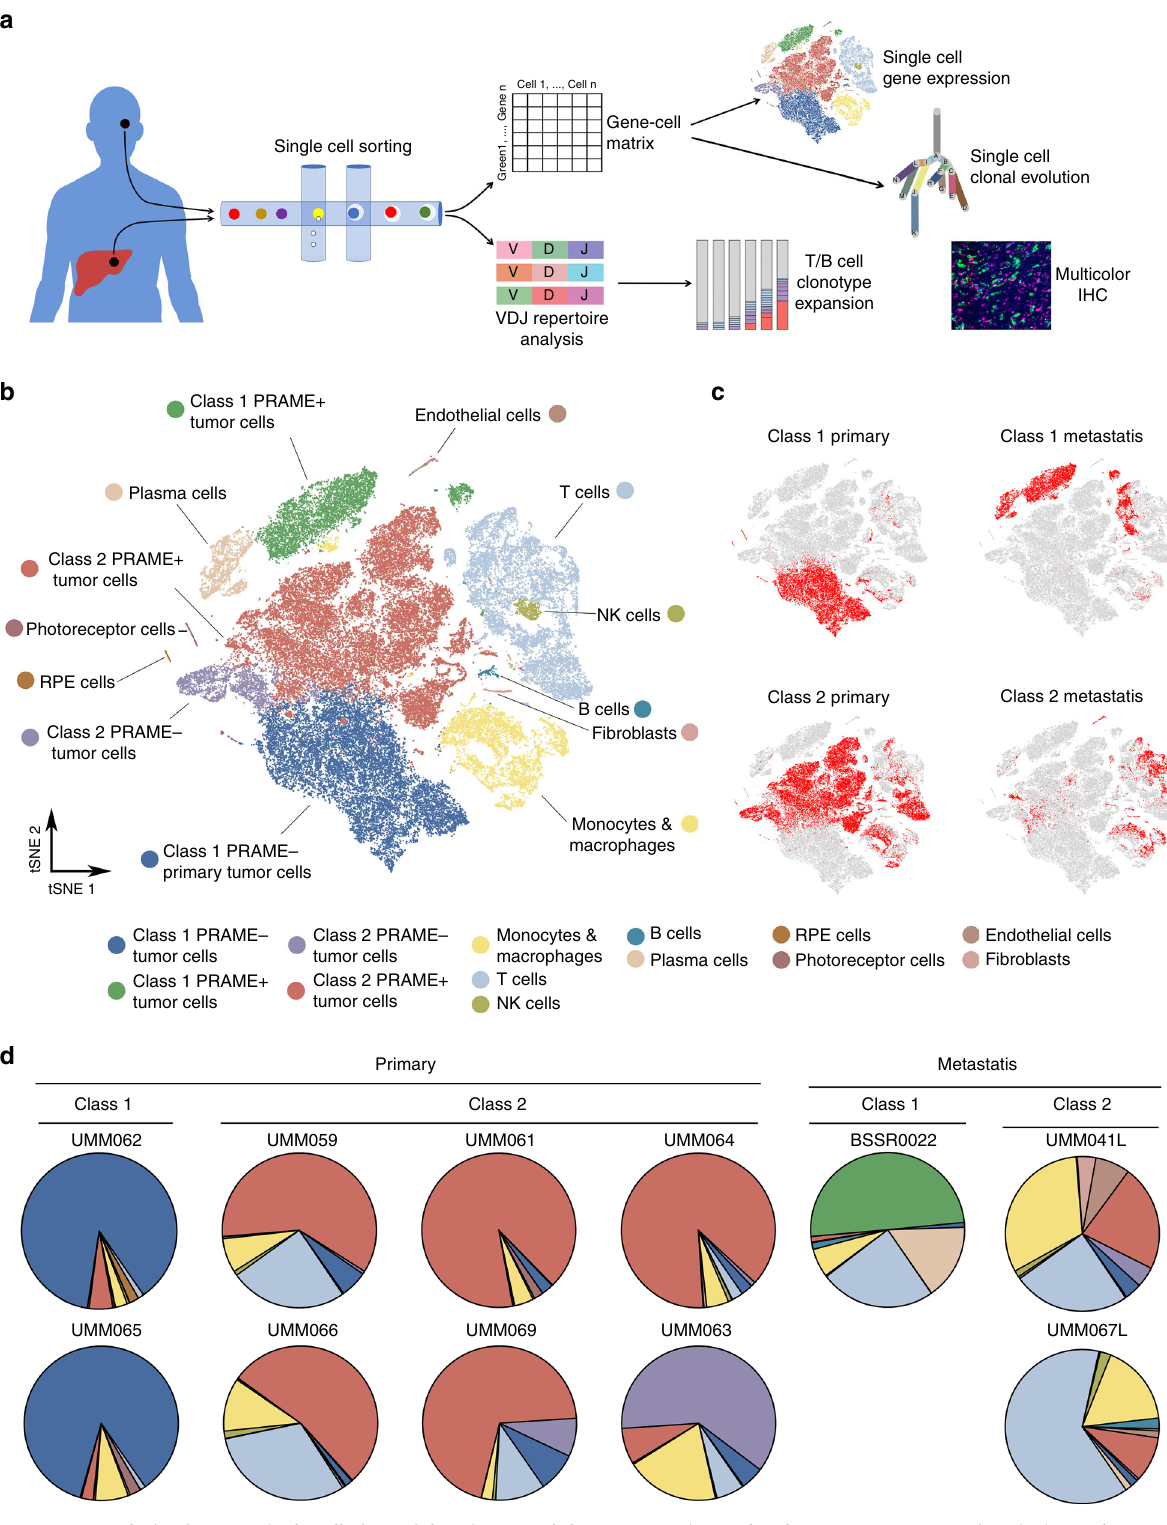
Fig. 1 Aggregate analysis of 59,915 single cells from eight primary and three metastatic uveal melanomas. a Summary of study design. b t-SNE plot of 59,915 single cells distributed by annotated unsupervised clustering. c t-SNE plot of 59,915 single cells highlighted by gene expression pro fi le (GEP) class. d Pie charts of each of the eight primary and three metastatic tumors showing percentages of annotated cell